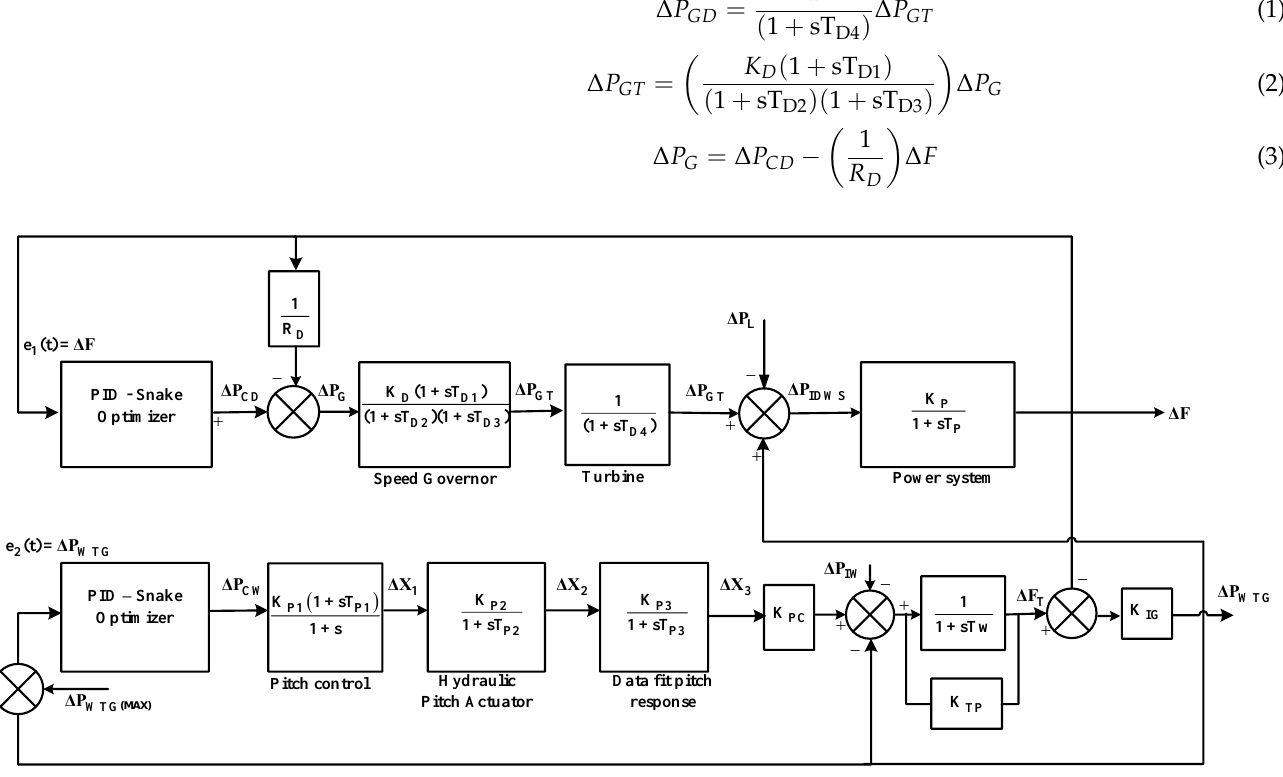
Figure 1. Diesel–wind isolated system.